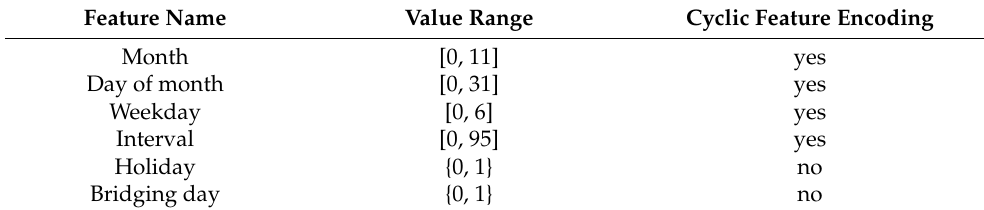
Table 1. Feature description for standard feature set.